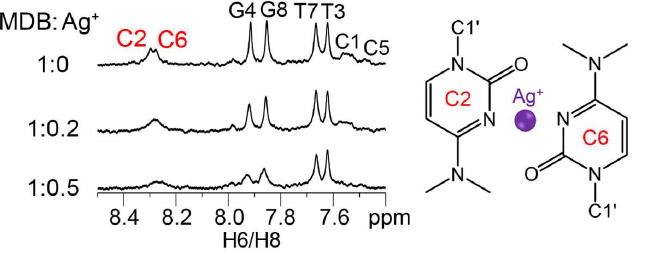
Figure 2. NMR spectra of 0.1 mM CCTG MDB in 1 mM sodium cacodylate (pH 6), 90% H 2 O/10% D 2 O, with various Ag + concentrations at 25 °C. Peak broadenings of C2 H6 and C6 H6 in the presence of Ag + suggest that Ag + is bound to C2·C6 mispair.